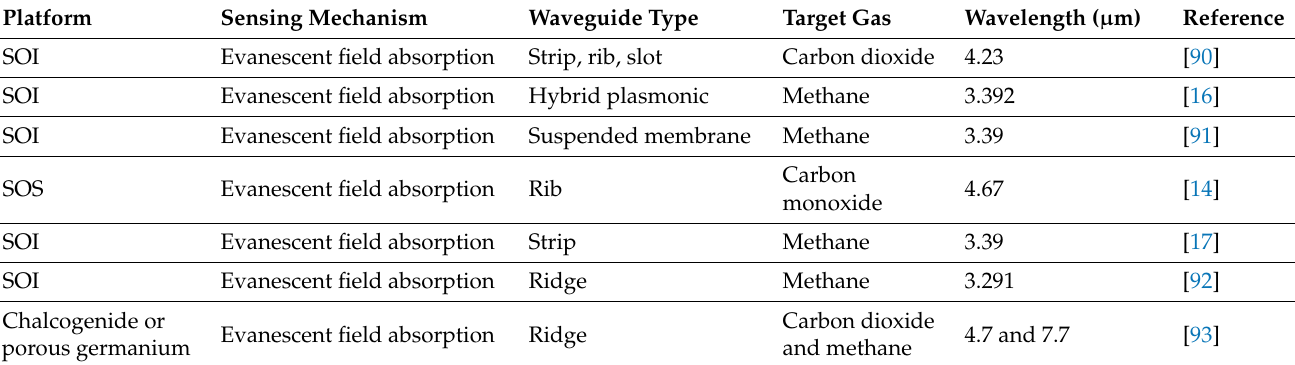
Table 2. Evanescent field absorption-based optical waveguide gas